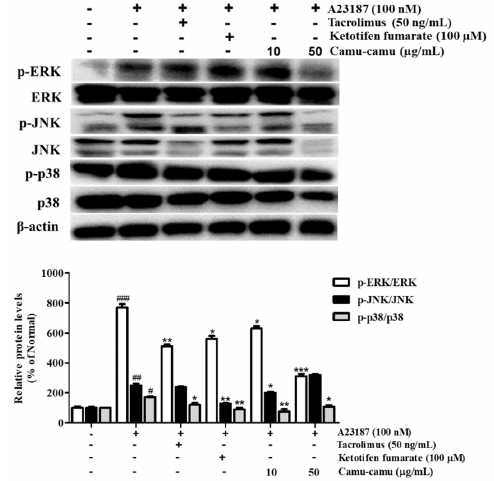
Figure 7. Effect of camu-camu fruit extract on MAPK activation in A23187-induced RBL-2H3 cells. Band intensities were quantified by densitometry, normalized to the level of β -actin. Then, it was calculated as a percentage of non-treated cells and displayed as mean ± SD of three independent experiments ( # p < 0.05, ## p < 0.01, and ### p < 0.001 vs. the control group, * p < 0.05, ** p < 0.001 and *** p < 0.001 vs. the A23187-treated group).